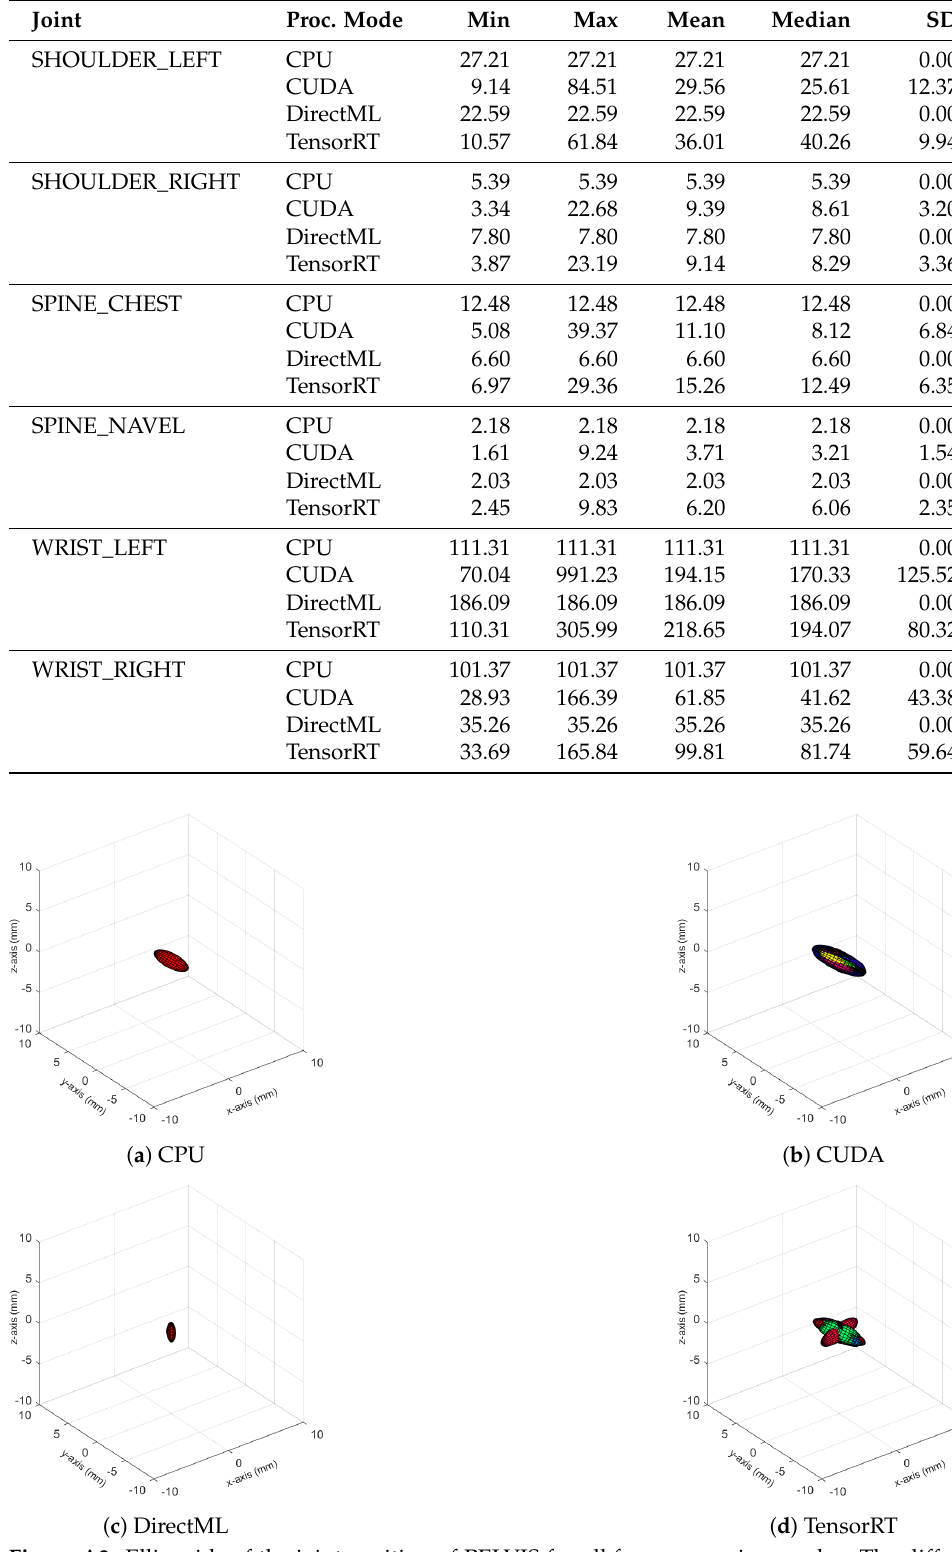
Figure A3. Ellipsoids of the joint position of PELVIS for all four processing modes. The different colors represent different body tracking